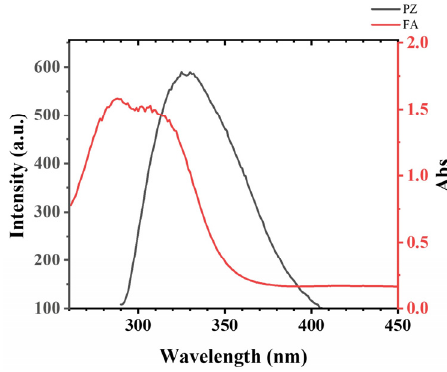
Figure 3. The overlap of the fluorescence emission spectrum of PZ with the absorption spectrum of FA. Conditions: λ Ex = 280 nm, 1.0 µ M PZ, 100.0 µ M FA, 50.0 mM sodium citrate buffer, pH 4.2, and 25 °C.